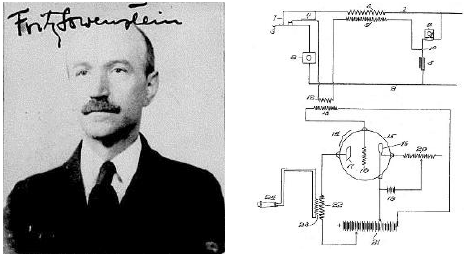
Fig. 6. Fritz Lowenstein and his patent US1231764 for an audion frequency amplifier with a negative offset to the grid